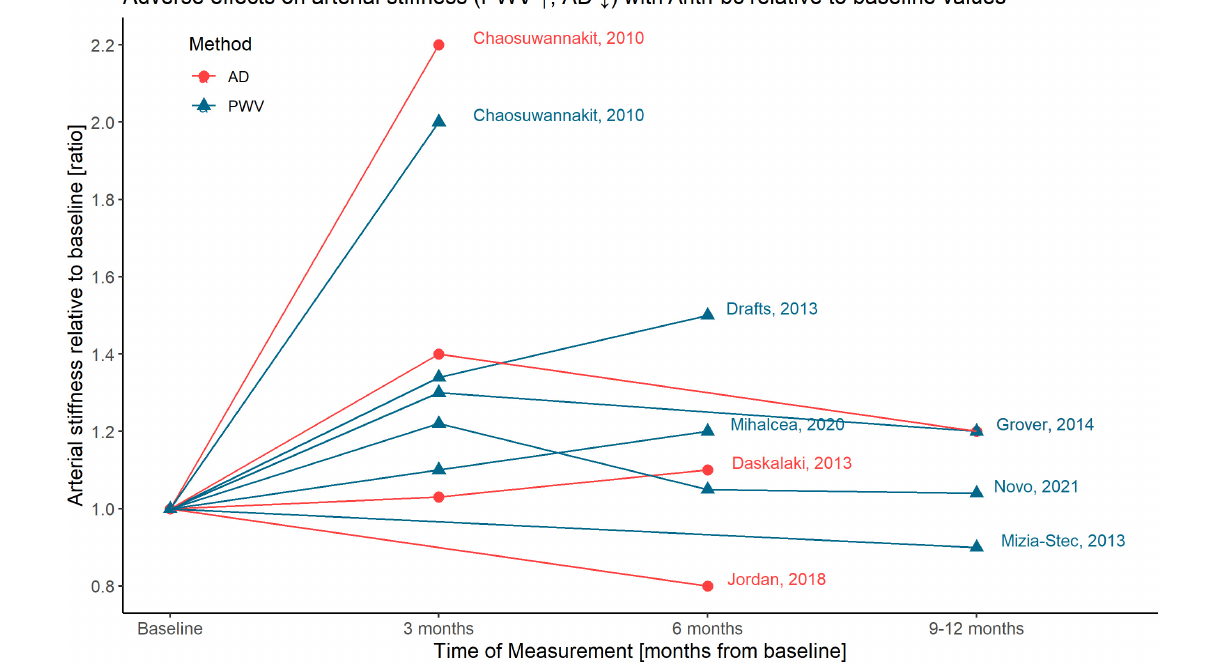
FIGURE 2 | Graphical illustration of time-dependent adverse effects on arterial stiffness with ANTH-BC relative to baseline values; AD, aortic distensibility; PWV,